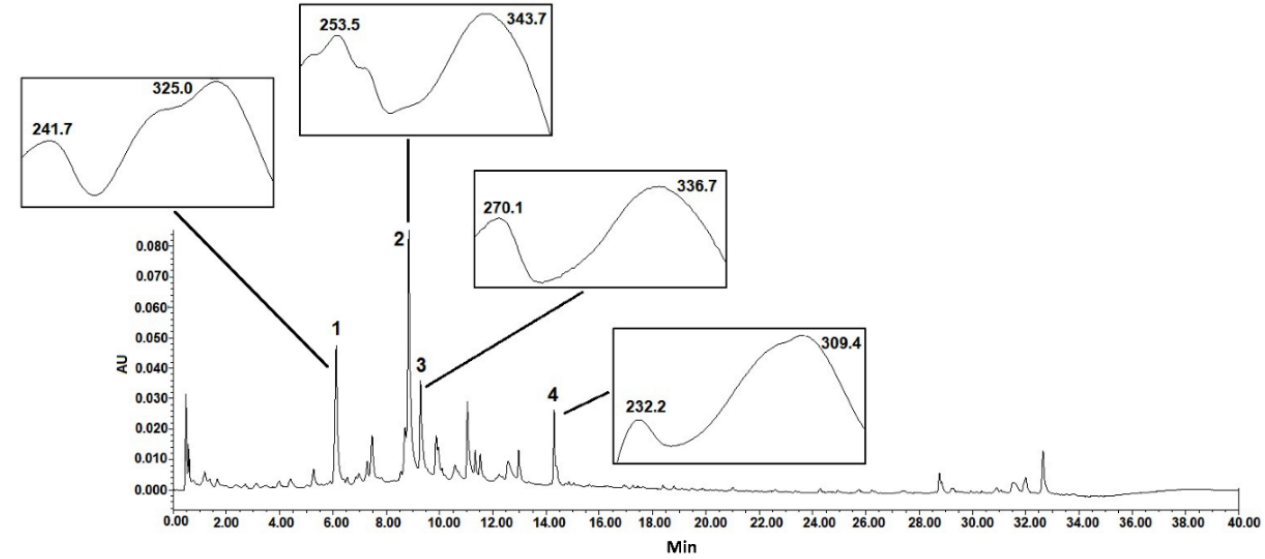
Figure 1. Chromatographic analysis of T. usneoides ethanolic extract at 254 nm and UV spectra. UPLC–PDA analysis was performed with an Acquity UPLC H ‐ class (Waters, Milford, MA, USA) and a Phenomenex Kinetex C 18 column (100 × 2.1 mm, 1.7 μ m). a Phenomenex Kinetex C 18 column (100 × 2.1 mm, 1.7 µ